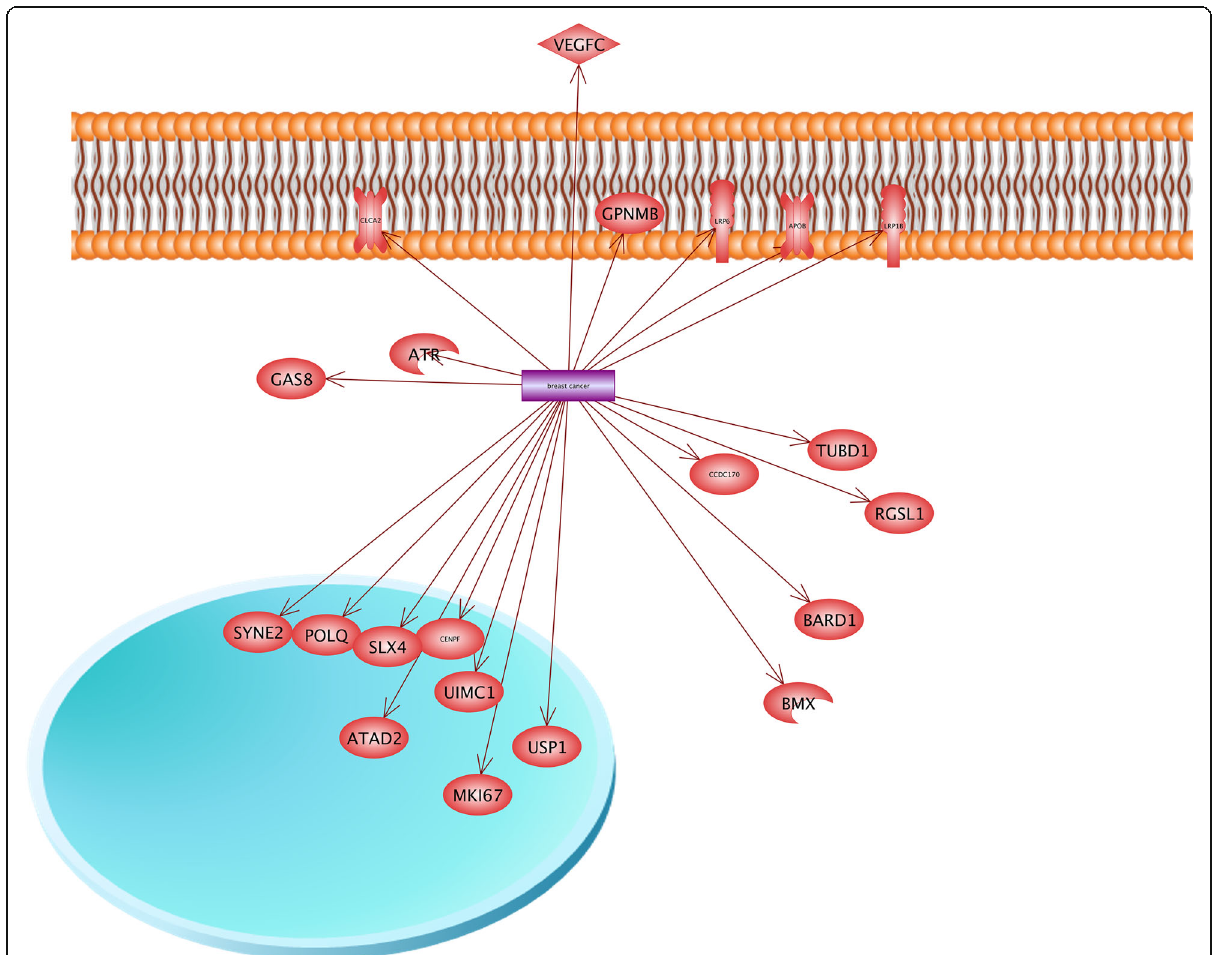
Fig. 11 Gene network analysis for the identification of roles of key candidate genes in breast cancer. Our gene network analysis indicated that two protein transporters including APOB (Apolipoprotein B) and CLCA2 genes are involved in breast cancer. APOB is one important member of body ’ s lipid profile and is considered as an essential factor for cholesterol hemostasis. The abnormal level of APOB is associated with different diseases including cardiovascular, inflammation, and tumorigenesis. Furthermore, it was reported that rs693 and rs1042031 polymorphisms that existed in the APOB gene increased the risk of breast cancer. Another result showed that CLCA2 is involved in the calcium-activated chloride channel regulator family and regulates transferring the chloride across the plasma membrane. The over-expression of the CLCA2 gene in negative cell lines of CLCA2 will lead to the reduction of metastasis and